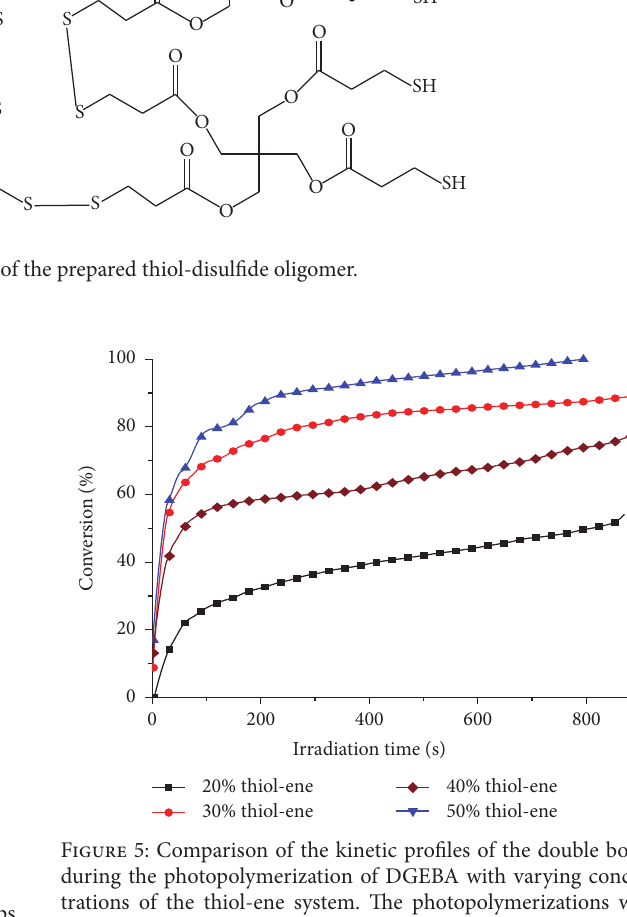
Figure 4: Comparison of the kinetic profiles of the epoxy groups during the photopolymerization of DGEBA with varying concen- trations of the thiol-ene system. The photopolymerizations were performed at a temperature of 85 ∘ C and UV light intensity of 40 mW/cm 2 . The photoinitiator DMPA and the catalyst TBP were added at 1%.